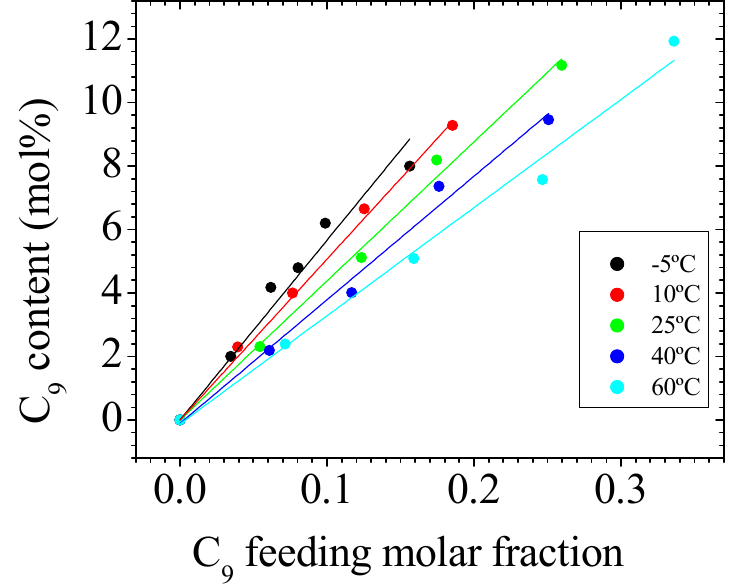
Figure 4. Variation of the C 9 content in the copolymers with the C 9 feeding molar fraction at the different T pol . A colour code is inserted into the figure.